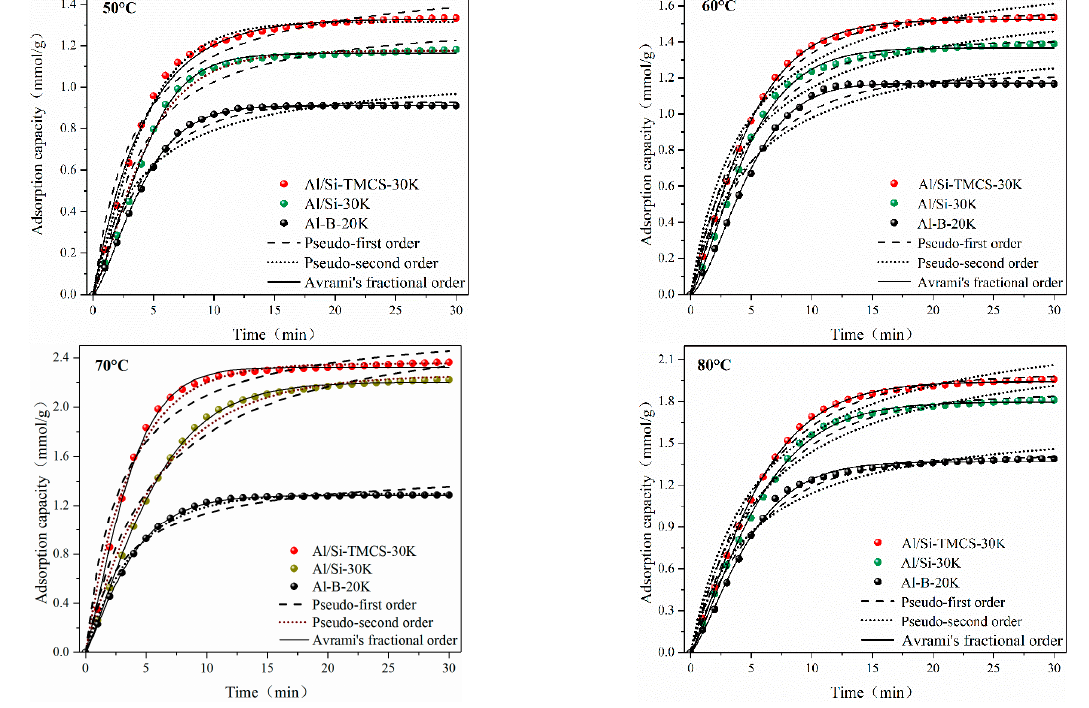
Figure 9. Adsorption kinetics fitting results of adsorbents at different temperatures. Table 4. The kinetic parameters obtained by di ff erent adsorption kinetic